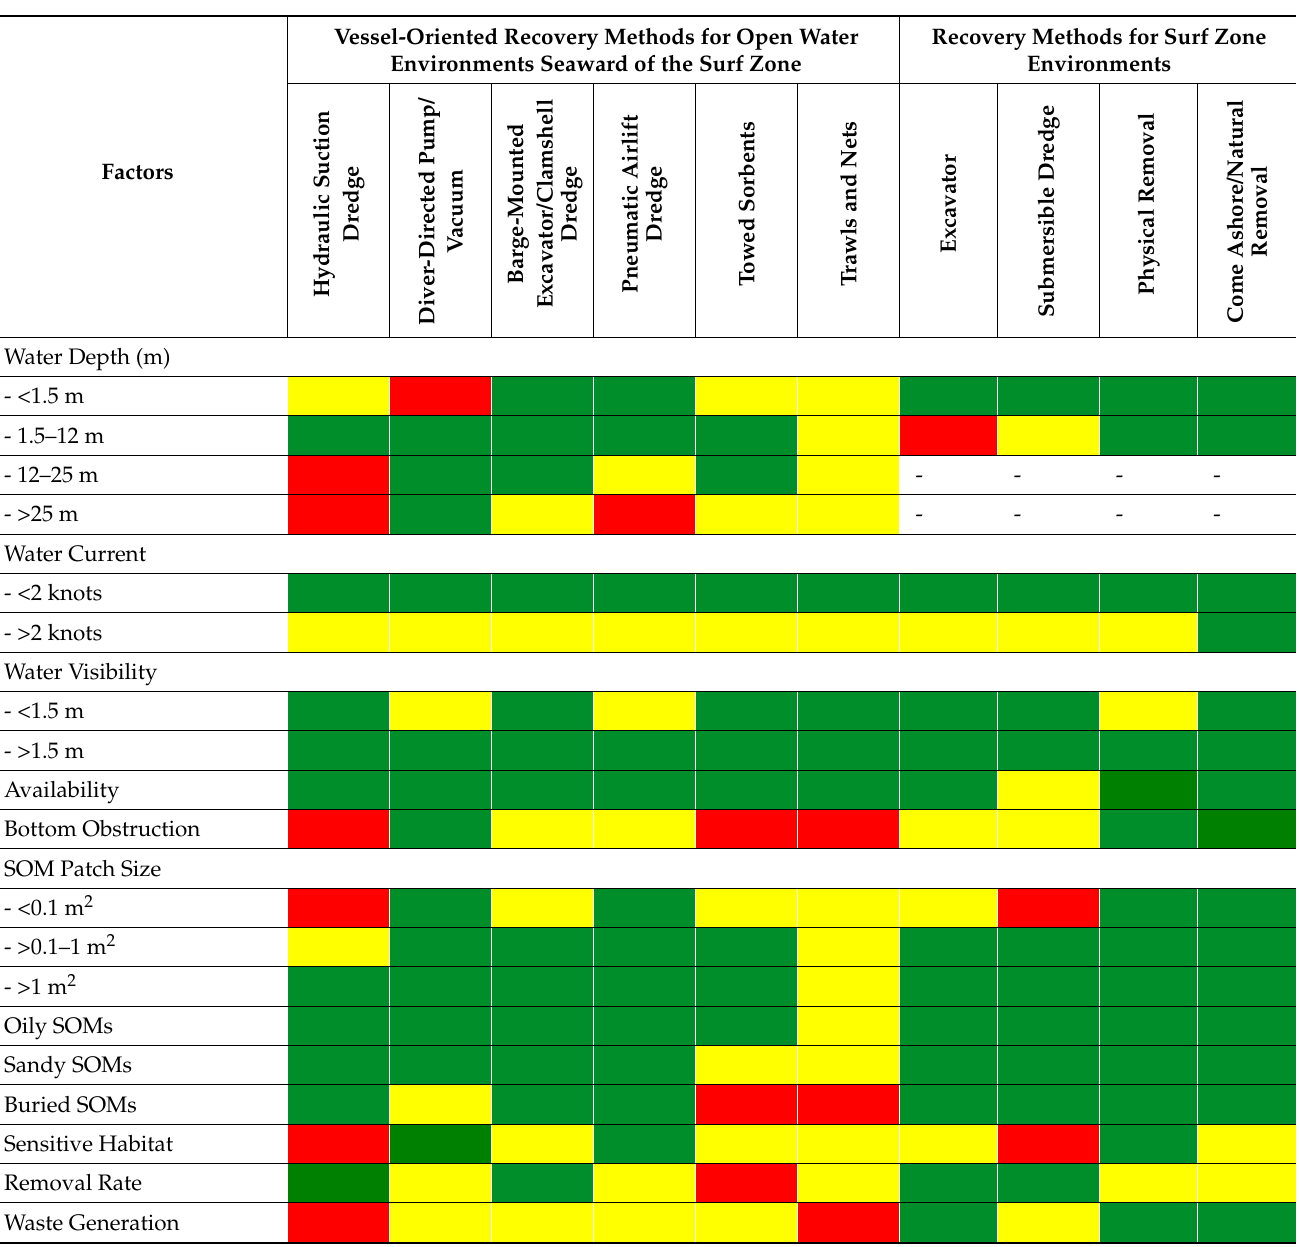
Table 8. Matrix to evaluate SOMs removal